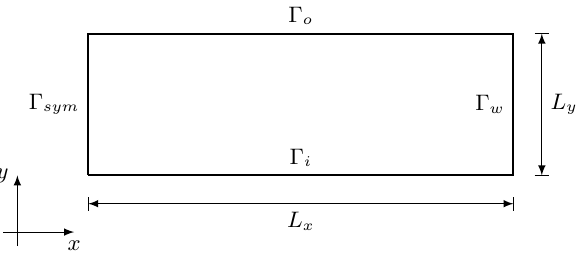
Figure 1. Plane channel: Sketch of the computational domain. Table 2. Physical properties employed for the numerical simulations.